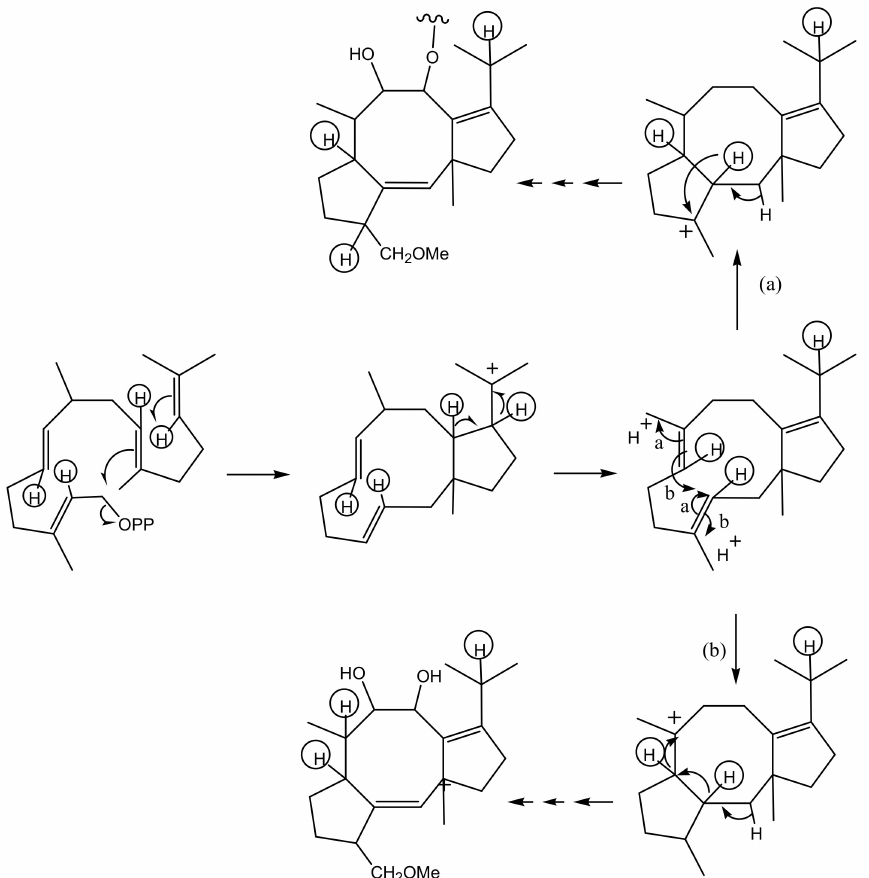
Figure 5. The two biosynthetic pathways of cyclization of GGPP into the characteristic 5:8:5 carbotri- cyclic skeleton of FC. Circled hydrogens arise from [(4 R )-4- 3 H 1 , 2- 14